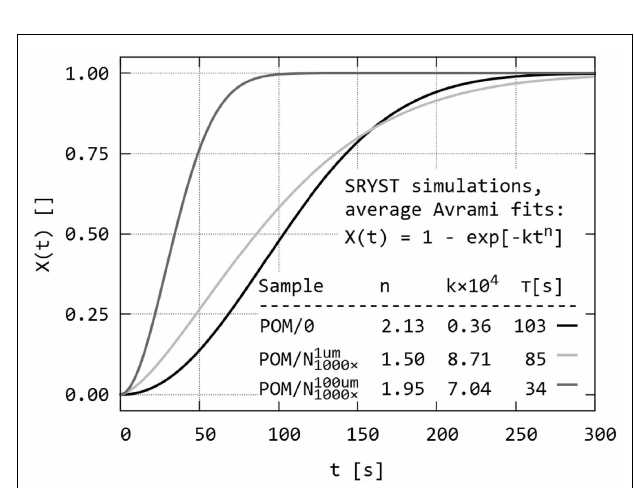
FIGURE 8 | Simulation of isothermal spherulitic crystallization in sandwich composites with program SCRYST: the first output of the program – simulated PLM micrographs . Upper row: empty sandwich POM/0; middle row: sandwich POM / N 1 µ m , with strong nucleant (primary 1000 × nucleation probability in the nucleant layer 1000 × higher than in the polymer